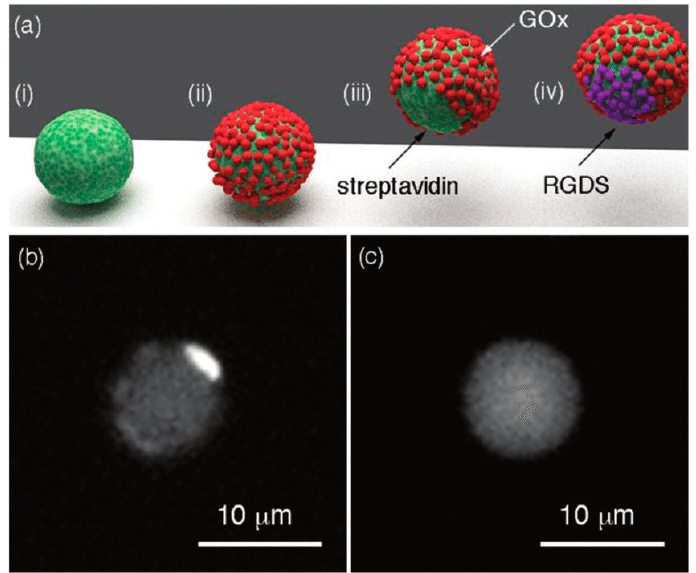
Figure 3. Synthesis and characterization of a specific Janus particle. ( a ) Schematics of glucose oxi- dase (GOx)-coated Janus particle formation, where (i) streptavidin-coated colloids with a magnet, (ii) Modification of the surface exposed to the solvent with biotinylated enzymes, (iii) Janus particles partially covered with enzymes after removal of the magnet, (iv) Biotinylated arginine-glycine-